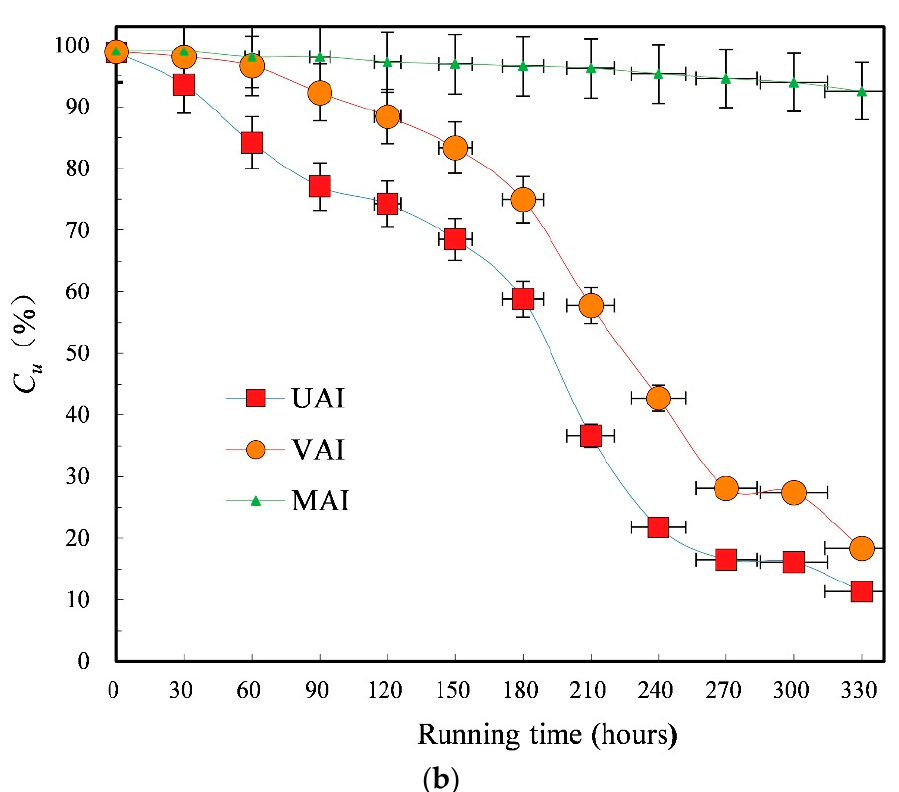
Figure 6. Variation curve of uniformity coefficient of drip irrigation system with irrigation time. ( a ) Statistical uniformity coefficient U s of drip irrigation system. ( b ) Christiansen uniformity coefficient C u of drip irrigation system.